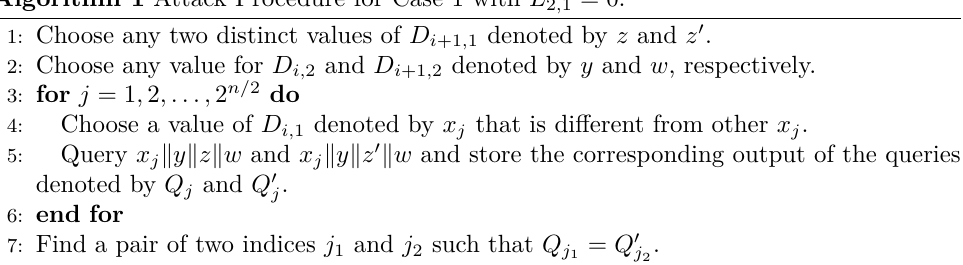
Figure 4: Differential Propagation for Case 1 with L 2 , 1 = 0. Algorithm 1 Attack Procedure for Case 1 with L 2 , 1 = 0.